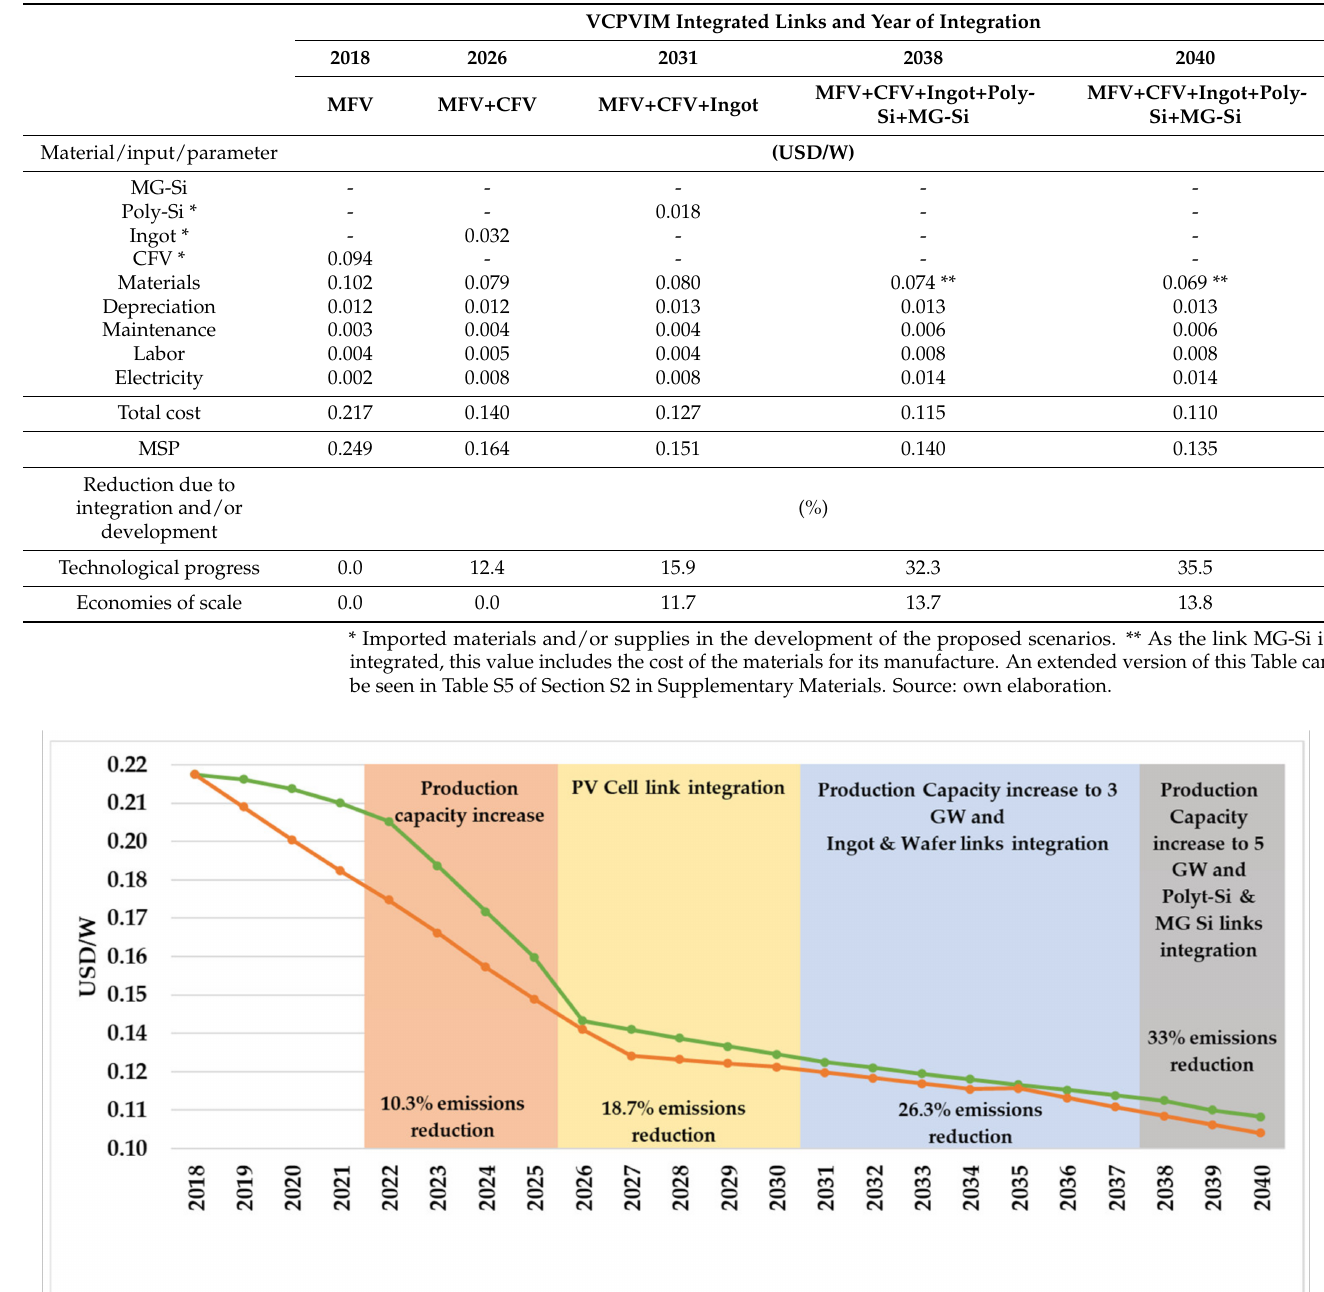
Table 11. Manufacturing costs and MSP in the Alternative Scenario, 2018–2040.